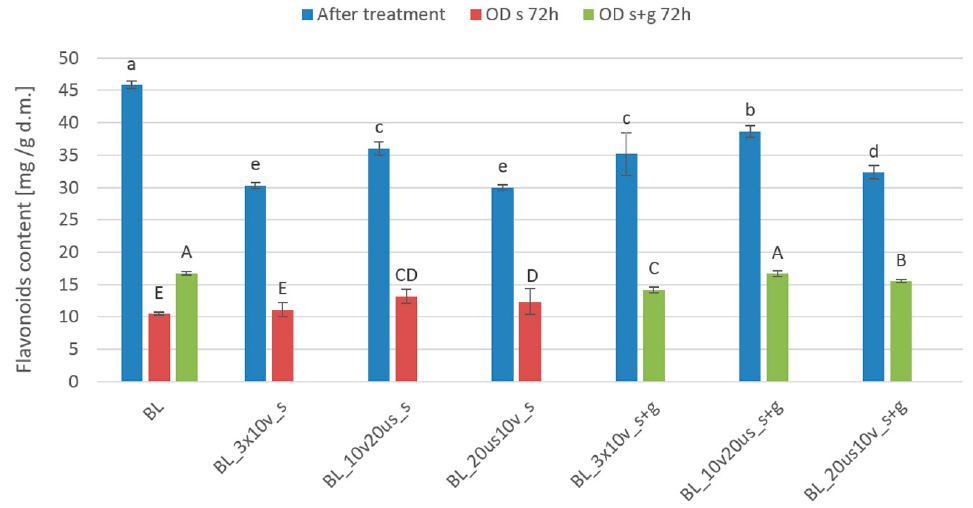
Figure 4. Flavonoids content in different treated cranberries: Blanched (BL), reduced pressure (BL_3 × 10 v), reduced pressure with sonication treatment (BL_10 v 20 us), sonication treatment with reduced pressure (BL_20 us 10 v), and after osmotic dehydration (OD) in 61.5% sucrose solution (s) and in 30% sucrose solution with 0.1% addition of steviol glycosides (s + g). Different lowercase letters means significant difference by the Duncan test ( p < 0.05) for samples after treatment, and different capital letters means significant difference by the Duncan test ( p < 0.05) for samples after 72 h osmotic dehydration.